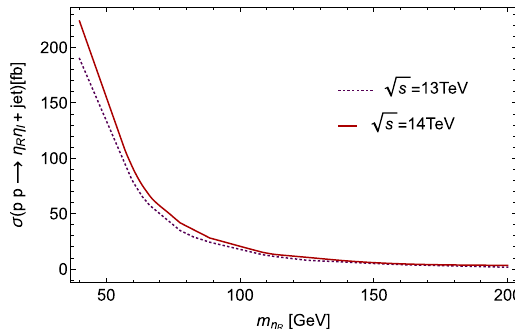
Fig. 9 Cross sections of mono-jet signals at LHC The left panel shows the Higgs boson mediated events from pp → η η + jet. The maximum value of the cross section is ∼ 1400 ( 1800 ) R R